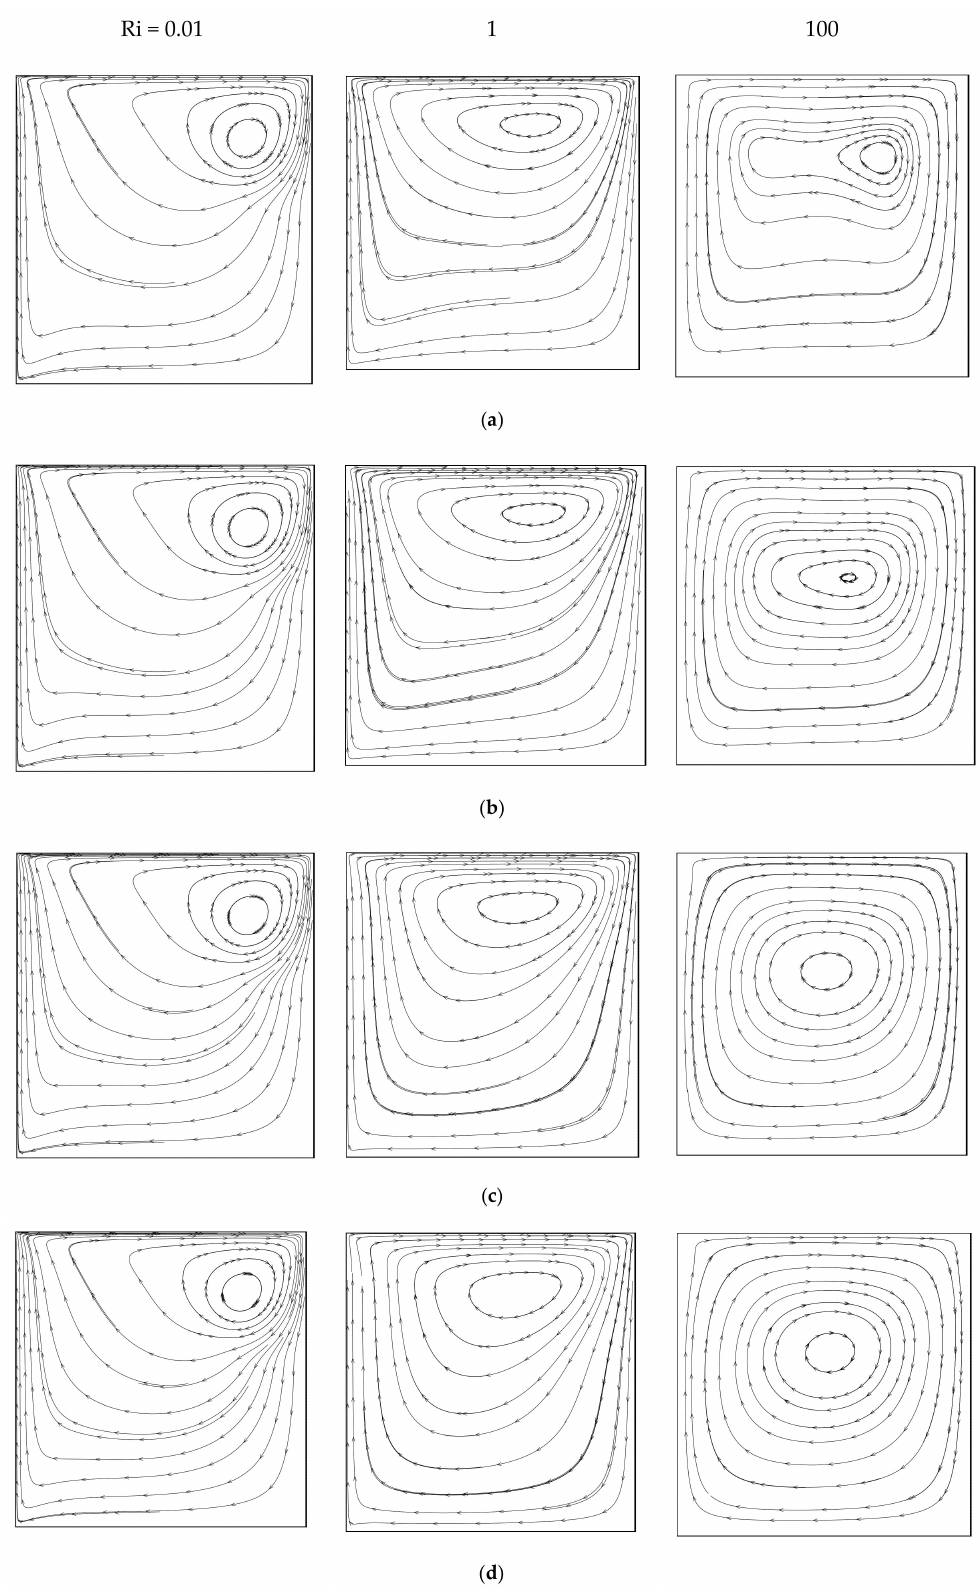
Figure 2. Streamlines for di ff erent Rd and Ri values with U 0 = + 1 (Case 1), and Φ = 0.02. ( a ) Rd = 0; ( b ) Rd = 1; ( c ) Rd = 5; ( d ) Rd =